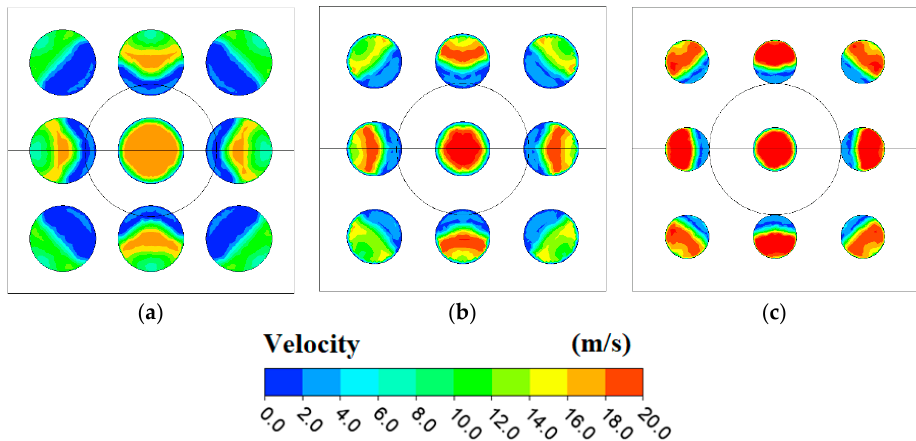
Figure 14. Velocity contours at the SPB cross-section ( ∆ L = 0) for three kinds of hole diameters, ( a ) Φ d = 30 mm, ( b ) Φ d = 25 mm, and ( c ) Φ d = 20 mm.